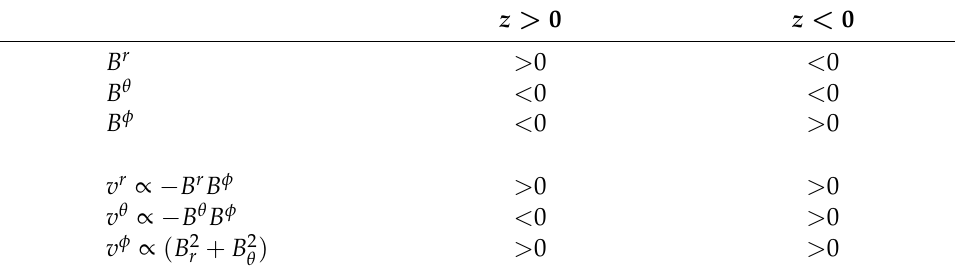
Table 2. Overview of the structure of a force-free jet model †